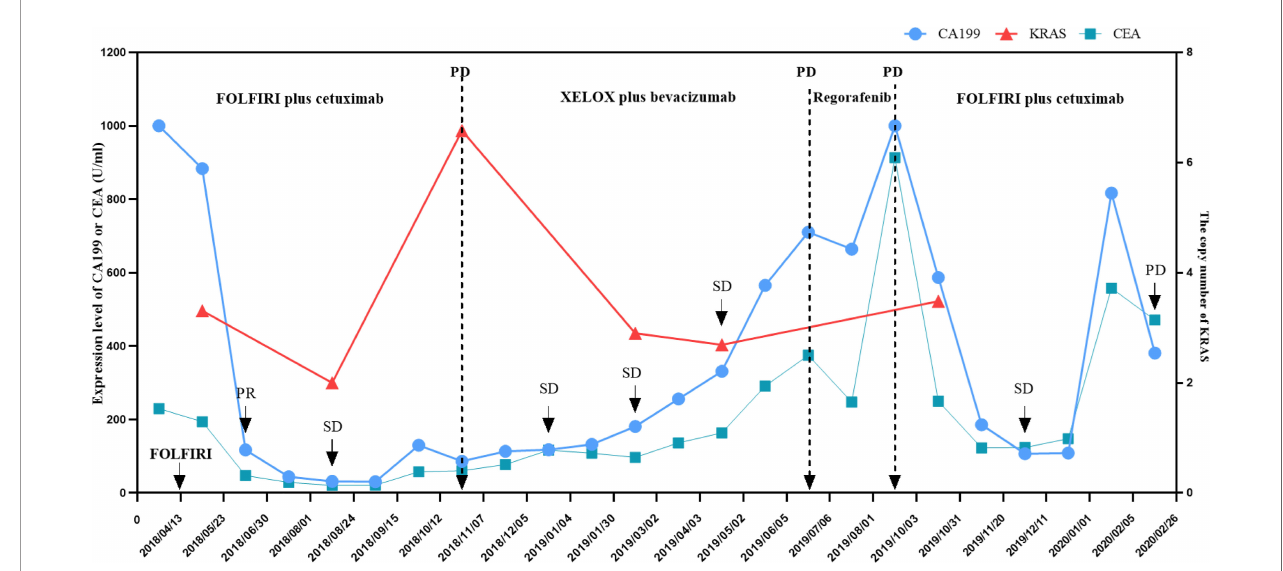
FIGURE 3 | Changes in KRAS copy number, CA199, and CEA level during anti-tumor treatment and follow-up of the patient. The KRAS copy number was measured in the patient ’ s circulating tumor DNA. The CA199 and CEA tumor markers were measured in the patient ’ s serum at periodic intervals throughout the clinical course and annotated with the date, therapeutic approach, and treatment ef fi cacy. CA199, cancer antigen 199; CEA, carcinoembryonic antigen; SD, stable response; PR, partial response; FOLFIRI, chemotherapy regimen containing irinotecan and fl uorouracil; XELOX, chemotherapy regimen containing capecitabine and